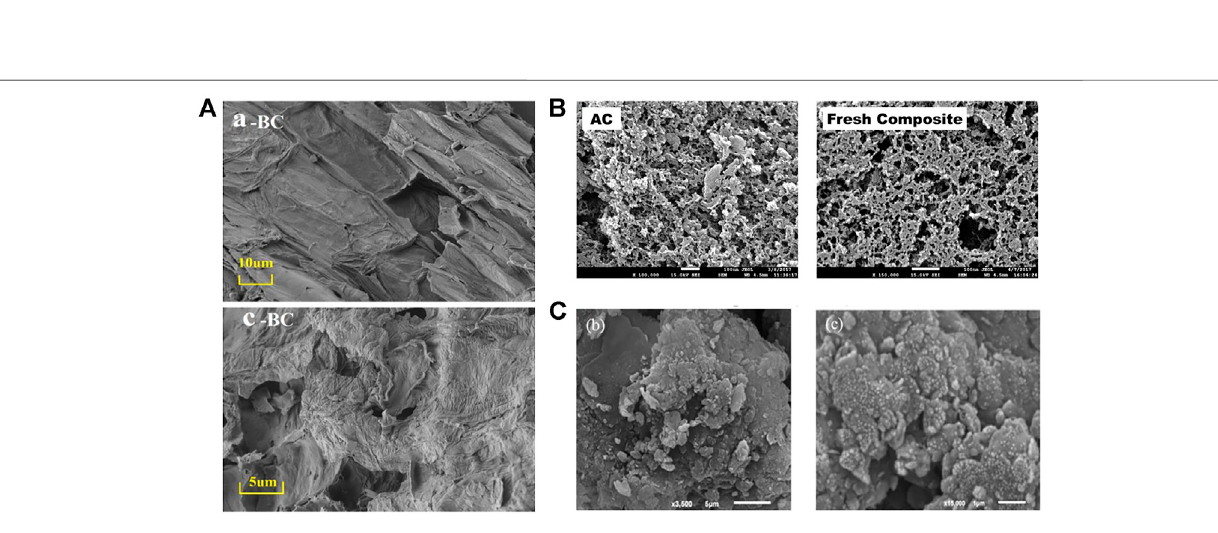
Frontiers in Chemistry |